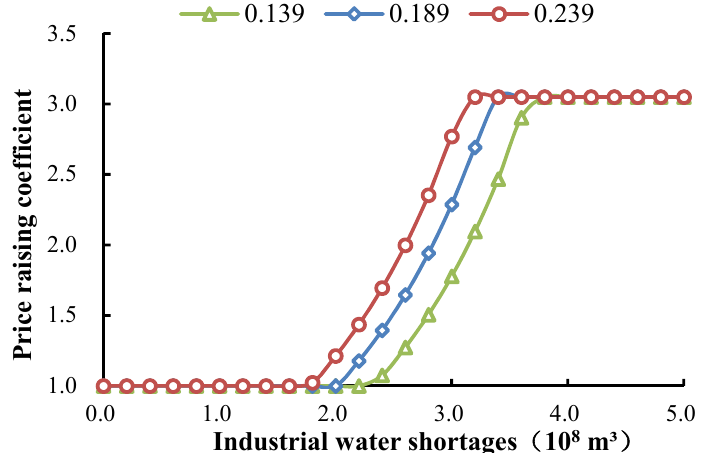
Figure 11. The impact of output elasticity of industrial water on PSRW.